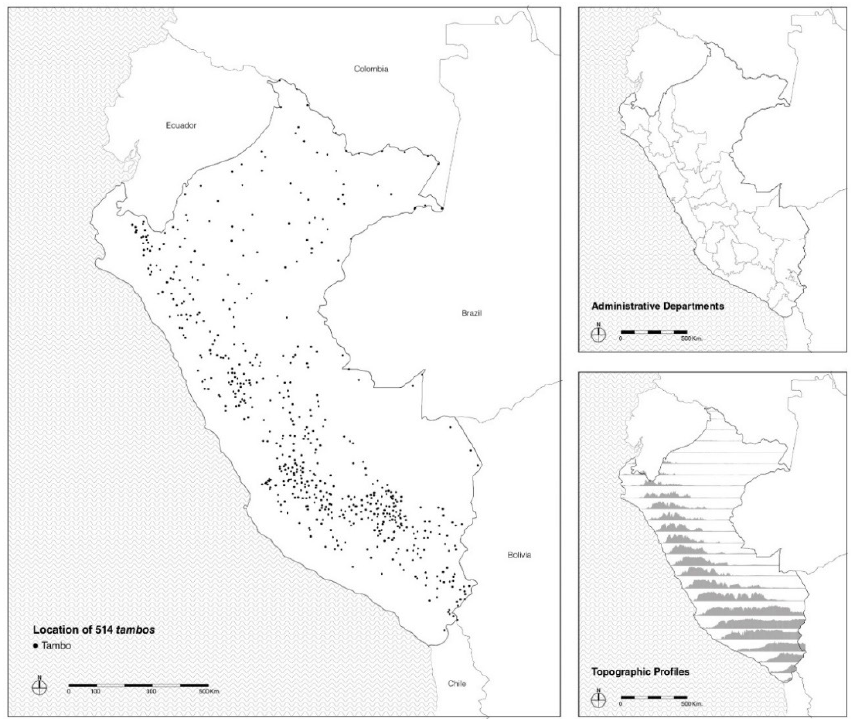
Figure 3. Location of the current 514 “tambos” in the Peruvian